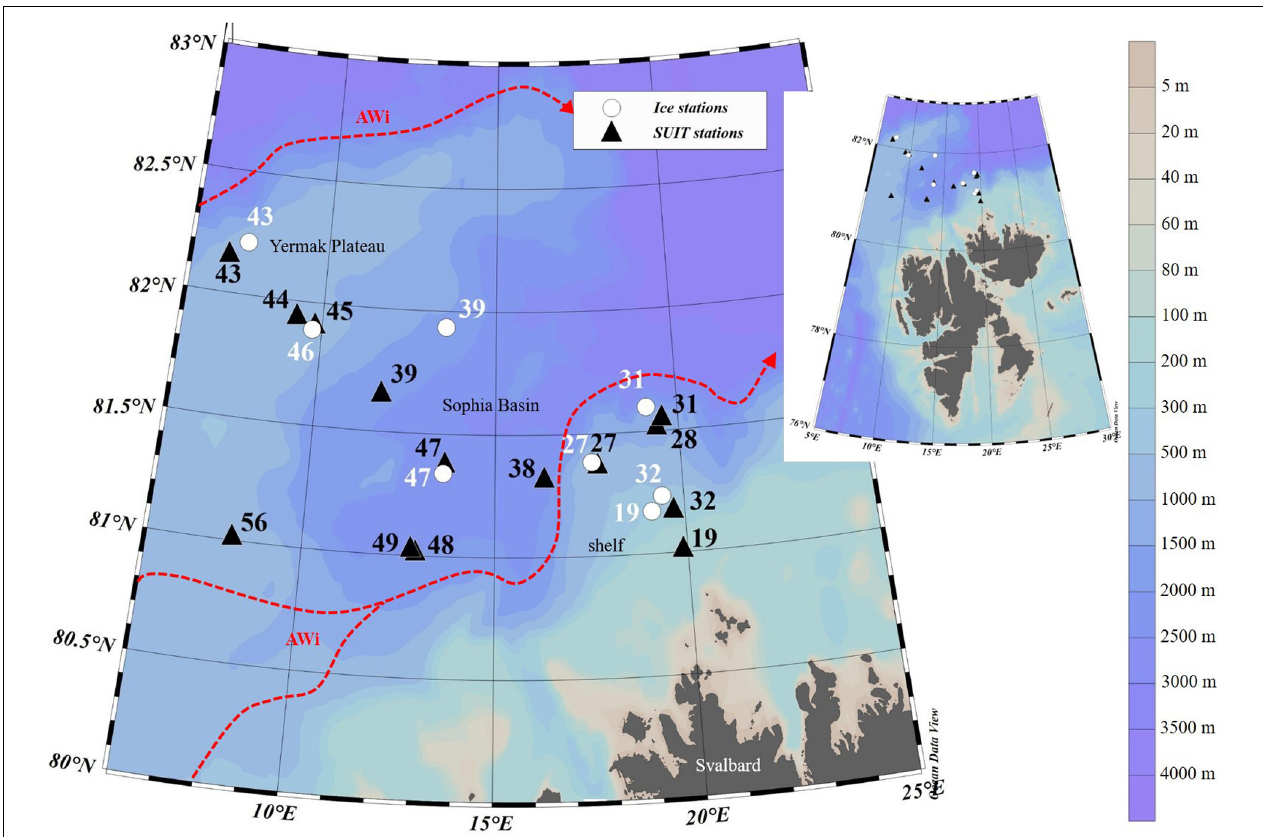
FIGURE 1 | Map of the sampled area north of Svalbard during the Polarstern expedition PS92 including the station numbers of ice and SUIT (Surface and Under-Ice Trawl) stations, the geographical regions, and the Atlantic Water inflow (AWi) originating from the West Spitsbergen Current (according to Renner et al., 2018). The map was created with Ocean Data View software version 5.1.7 (Schlitzer et al.,